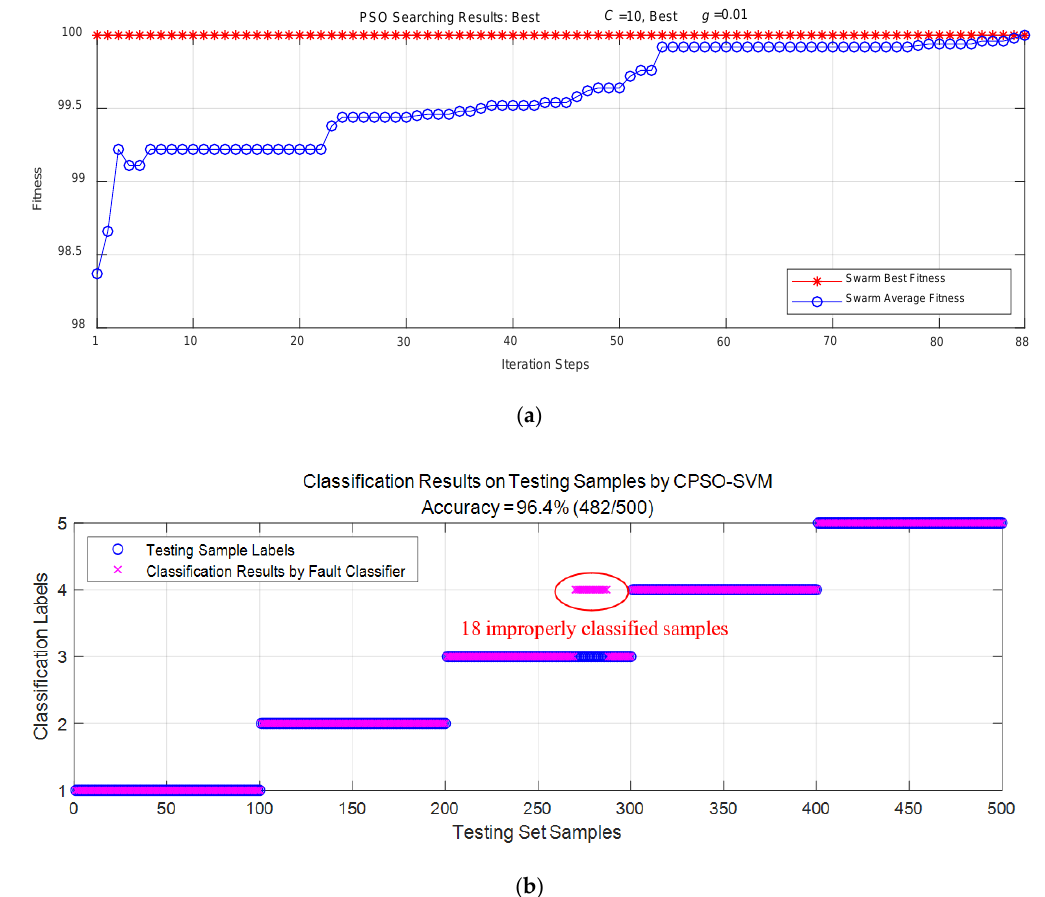
Figure 19. Fault classification results on testing set by CPSO-SVM with SVM parameters C = 10 and g = 0.01 optimized by CPSO. ( a ) Swarm average fitness evolving process along with iterations (88 iteration steps to converge with constant c 1 = c 2 = 1.5 and ω = 1 in PSO). ( b ) Fault classification results of CPSO-SVM (classification accuracy = 96.4%). Table 5. Simulation results statistical data of the three comparative methods. SVM